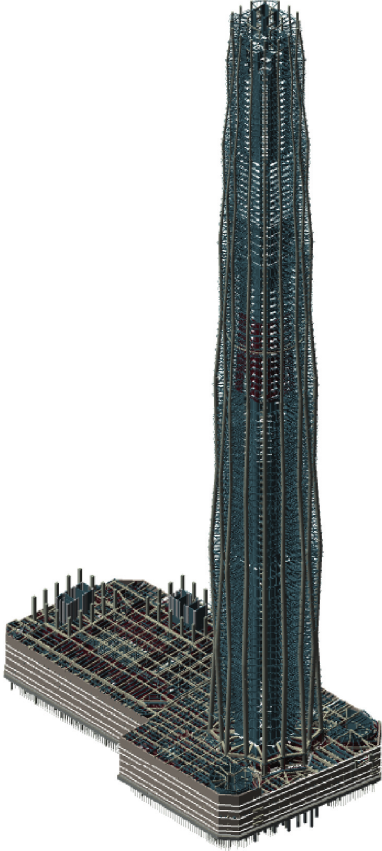
Figure 10: The developed 3D BIM